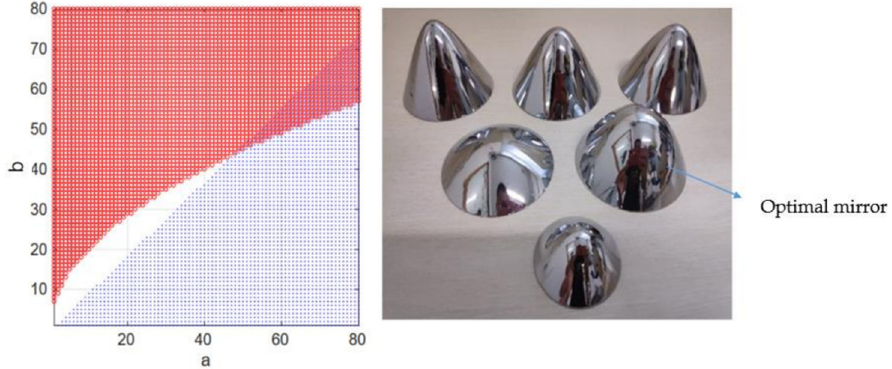
Figure 5. Feasible intersection of two solution spaces (left) and real image of mirror (right).